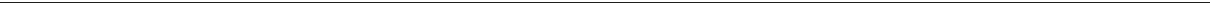
Fig. 2 Differential expression of TSSs and genes in IBD. a Principal component analysis (PCA) based on CAGE TSS regions. X - and Y -axes show principal components (PCs) 1 and 2, percent of variance explained is indicated. Dots correspond to subjects, colored by group. Boxplots at the bottom and right show the distribution of PC. Circles show three major groups: CDa, UCa, and non-in fl amed samples (UCi, CDi, and Ctrl). b Number of differentially expressed TSSs. Bar plot shows the number of differentially expressed TSSs in the four de fi ned groups. c Gene ontology (GO) term overrepresentation analysis of differentially expressed genes. X -axis shows GO term overrepresentation FDR values on − log 10 scale for differentially expressed genes in the IBD up , IBD down , and CD spec sets. Y -axis shows the top 10 GO terms, ordered by FDR. d Identi fi cation of IBD-upregulated genes with extreme variance across IBD patients. Y -axis shows the variance of CAGE expression across CDa, UCa, and Ctrl subjects. X -axis shows the F -statistic from edgeR. Dots correspond to genes, where size indicates the average CAGE expression in respective group. Five outliers are highlighted, corresponding to antibacterial peptides. e FANTOM5 cell type enrichment of differentially expressed TSSs. Differentially expressed TSS sets were analyzed for overlap with TSSs speci fi cally expressed in cell types in FANTOM5. X -axis shows under/over-representation of a given cell type expressed as log 2 (odds). Whiskers indicate 95% con fi dence intervals. Whiskers with black lines indicate statistical signi fi cance (Fisher ’ s exact test, FDR < 0.05). Cell types are ordered by their log-odds ratio in IBD up . Numbers in parentheses indicate the number of IBD-expressed TSSs speci fi cally expressed in respective cell type in FANTOM5. Red shading shows cell types only enriched in CD spec TSSs, blue indicates cell types only enriched in UC spec TSSs. f Correspondence of TSSs upregulated in IBD with TSSs upregulated after TNF stimulation in epithelial organoids and blood monocytes. Venn diagram shows the number of TSSs (out of 36) upregulated in IBD (UCa or CDa vs. Ctrl), upregulated after TNF stimulation in gut epithelia organoids or blood monocytes, measured by qPCR. Upregulation after 4 and 24 h of TNF stimulation are pooled; see Supplementary Fig. 3c for time-speci fi c